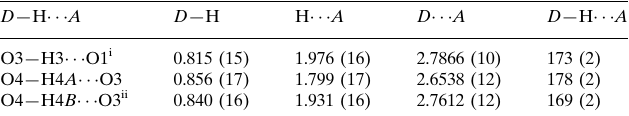
Hydrogen-bond geometry (A˚ , (cid:3)